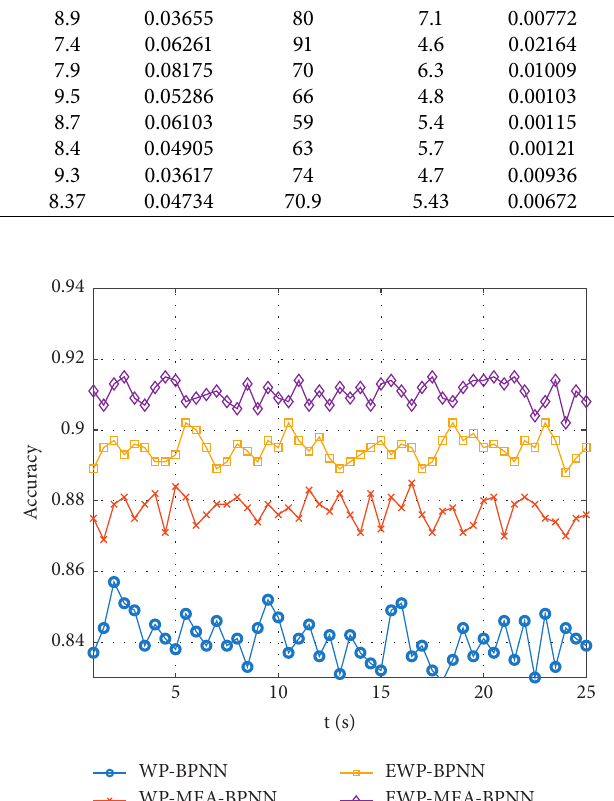
Figure 15: The diagnosis result for the high-order harmonic running condition.